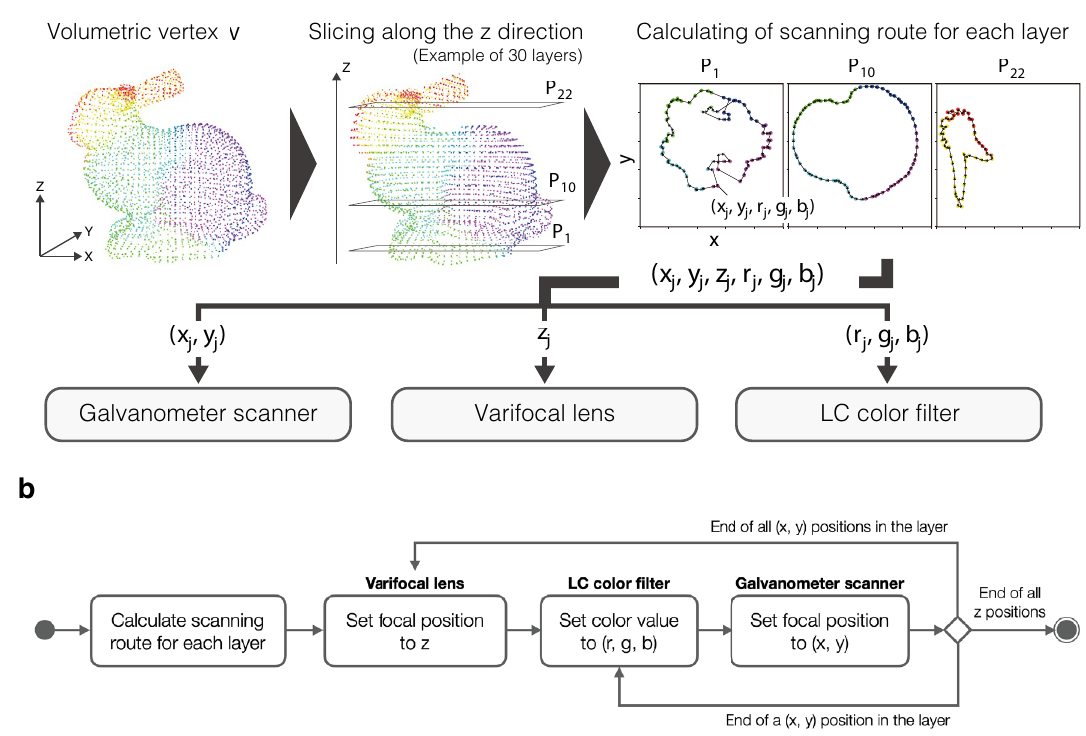
Figure 7. Procedure for voxel generation route acquisition. ( a ) Volumetric vertex data are sliced in layers along the z direction. The optimal scanning route is applied to the galvanometer scanner ( x , y ), varifocal lens z , and LC color filter ( r , g , b ). The 2D cross sections P 1 , P 10 and P 22 of a 30-sliced Stanford bunny with different vertex colors are presented as an example. ( b ) Synchronous operation flow to apply the 3D coordinates and color patterns to each device. This figure was created using Adobe Illustrator 2021 version 25.4.1 (https:// www. adobe. com/ produ cts/ illus trator.